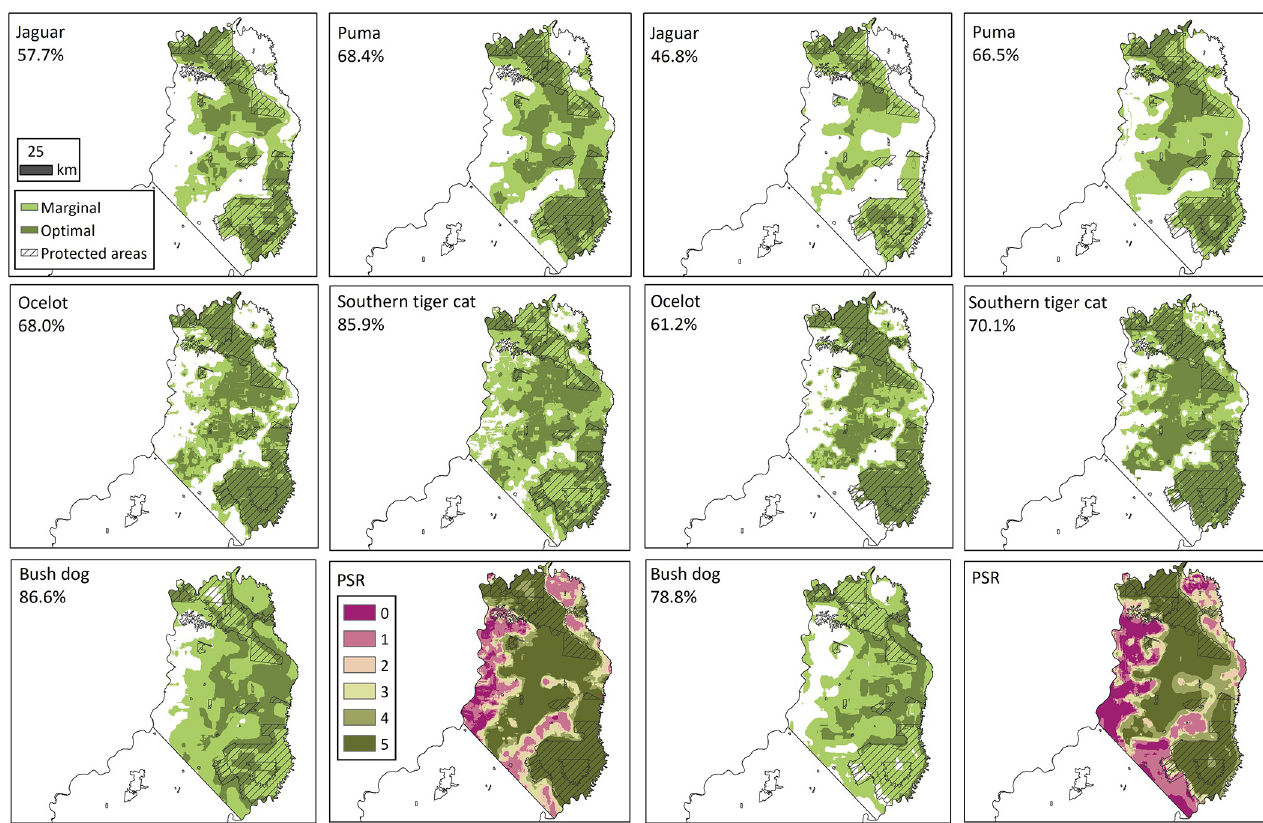
Fig 2. A summary of the proportion (%) of marginal and optimal habitat defined as suitable in the northern-central zone for Model 1 (left) and Model 2 (right), with these two measures equal to the binary prediction of proportion (%) of total suitable habitat. Included are the five species-specific ecological niche models and the potential species richness (PSR) that quantifies the overlap (0–5 species) among those areas defined as suitable for each carnivore. The latter is only represented as a binary prediction.